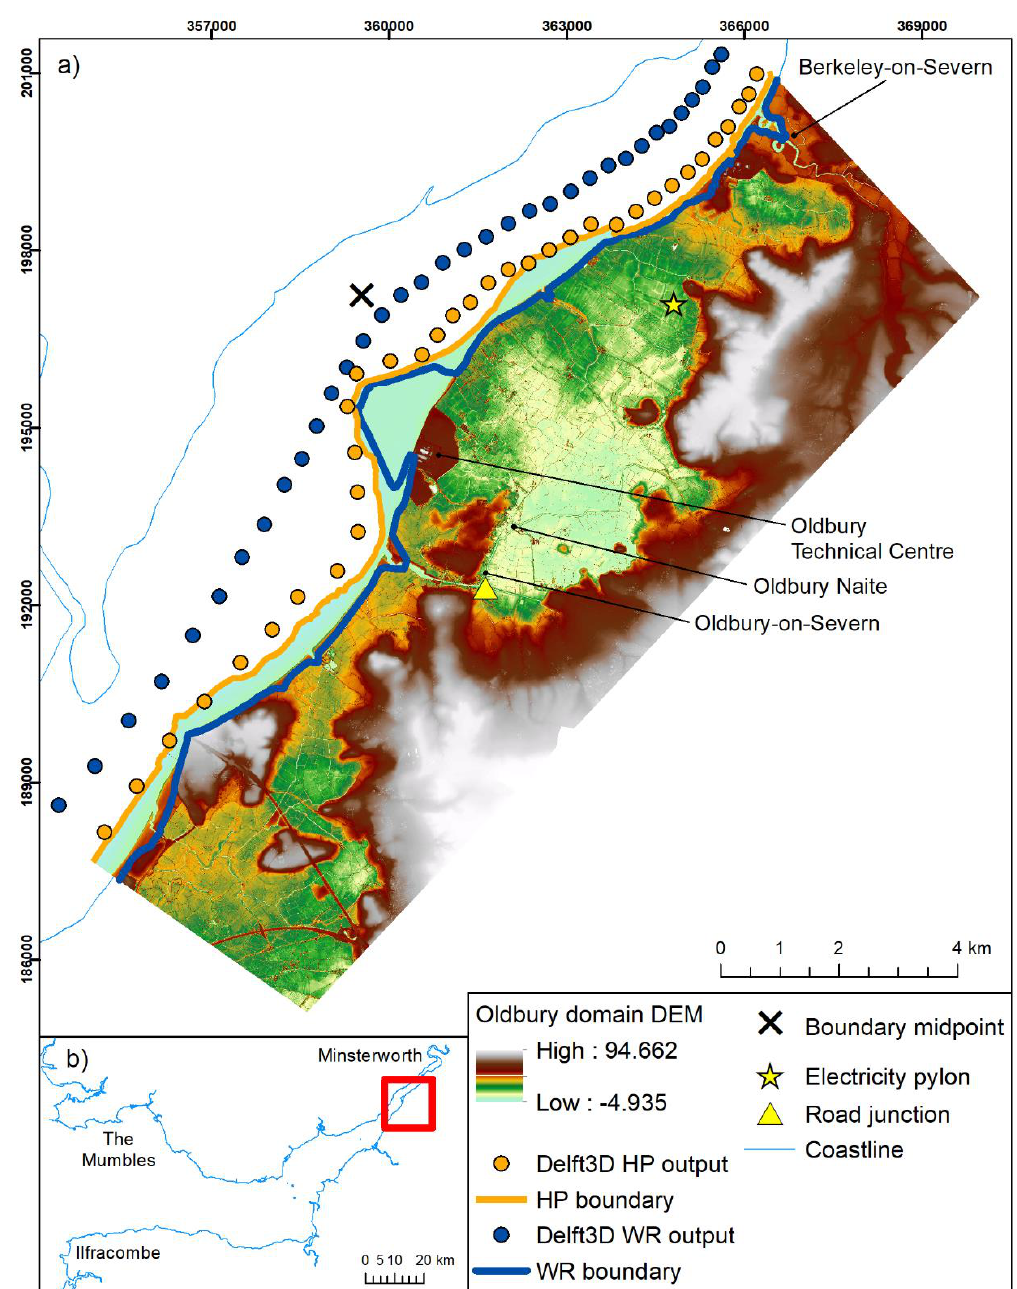
Figure 1. ( a ) Oldbury model domain, including the location of Delft3D outputs (coloured dots) used to force the hazard proxy (HP) and wave runup (WR) boundary approach (coloured lines); boundary midpoint to calculate change in coastal hazard uncertainty (black cross); sites of critical infrastructure (yellow star and triangle); and ( b ) Delft3D model domain with extent of the up-estuary Oldbury model domain shown.